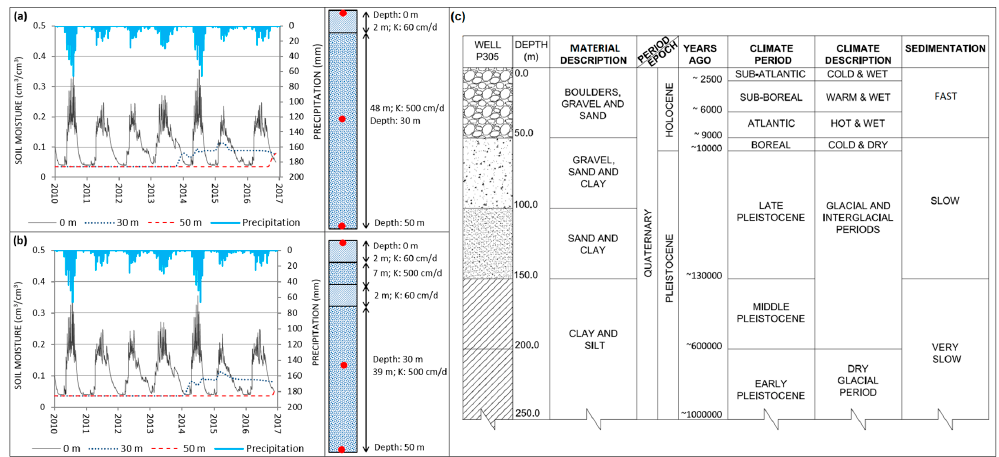
Figure 6. ( a ) Variation with time of soil water content at three different depths (i.e., 0, 30 and 50 m), and where a semipermeable layer is located at the top; ( b ) Same as in an additional